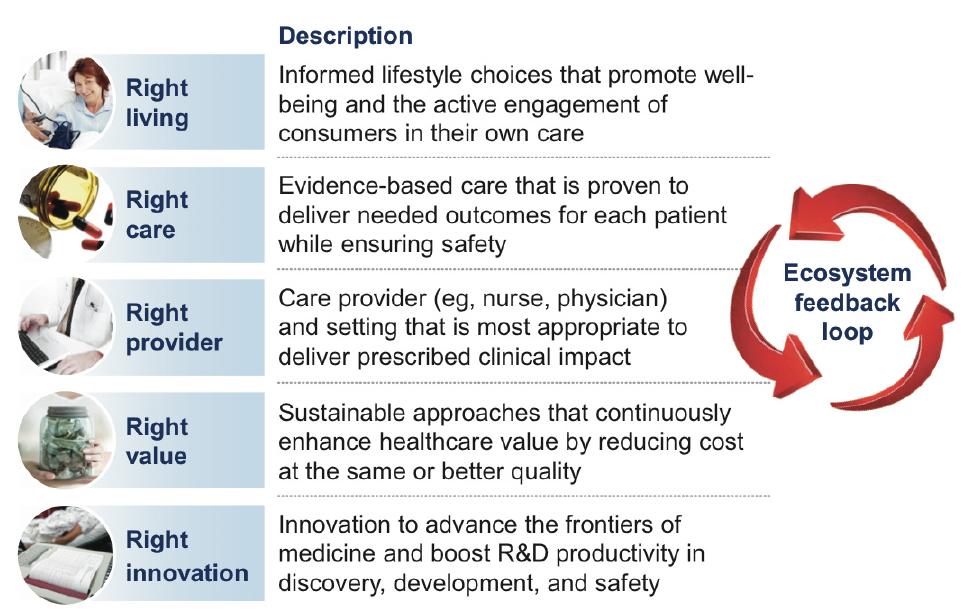
Fig. 2 New pathways that have impact on big